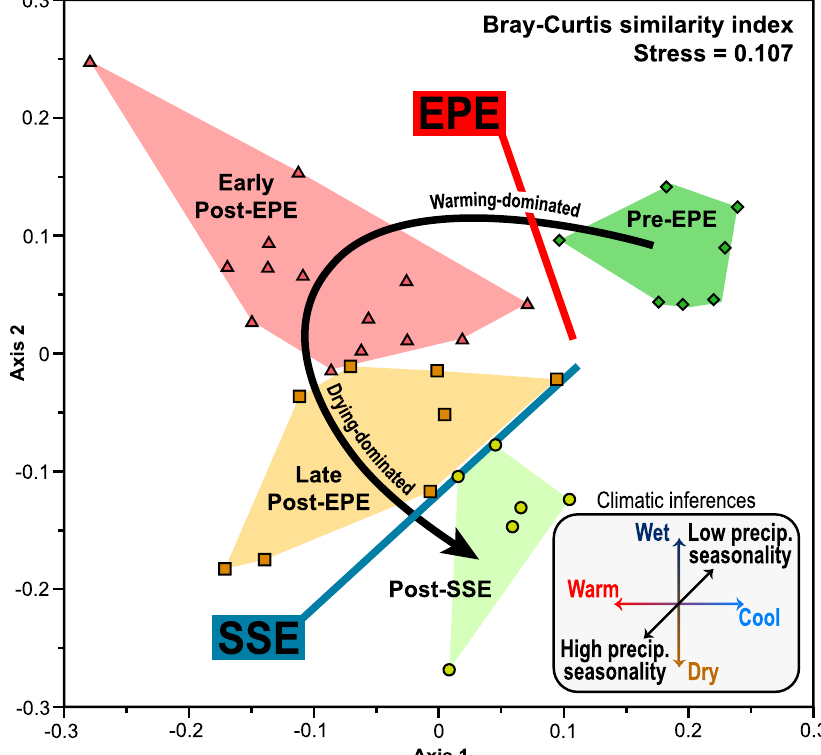
Fig. 3 Non-metric multidimensional scaling (nMDS) plot for the ecological phases of the Late Permian to Early Triassic, based on organic microfossil assemblages of the Sydney Basin, Australia. Insert box indicates inferred climatic changes through this interval, based on plant fossils, sedimentary features and climate modeling 7,12 – 14 . Large arrow indicates the progression of phases in stratigraphic order; EPE = end-Permian extinction event, precip precipitation, SSE = Smithian-Spathian climatic event. Source data are provided as a Source Data fi le.